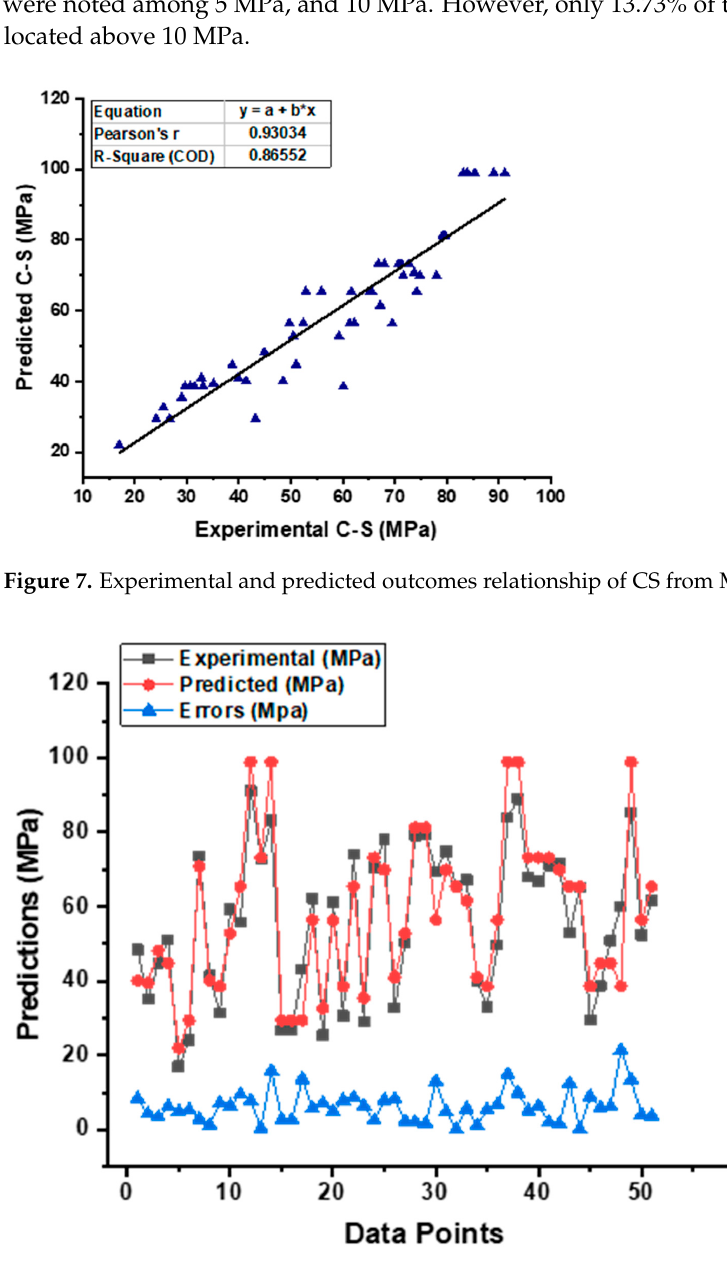
Figure 9. Box plot for predicted and experimental outcomes from MLP model. 5.2. SVM Model Output As shown in Figure 10, the SVM model provides a superior link between the experimental CS of SCC and the projected outcome when compared to the MLP model, which results in an R 2 value of 0.90 having been determined. Figure 11 is an illustration of the distribution of the data, which shows the disparity between the actual and the targeted values. The greatest value, the minimum value, and the average value, all based on this